Question: Write a single sentence explaining what this figure depicts.
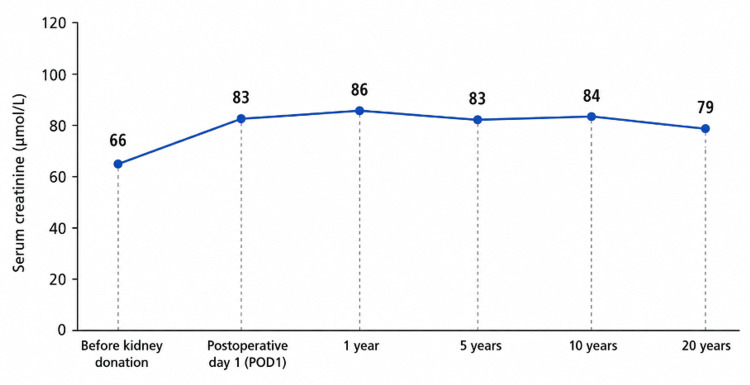
Answer: Longitudinal evolution of the mean serum creatinine levels during 20 years of follow-up after living kidney donation